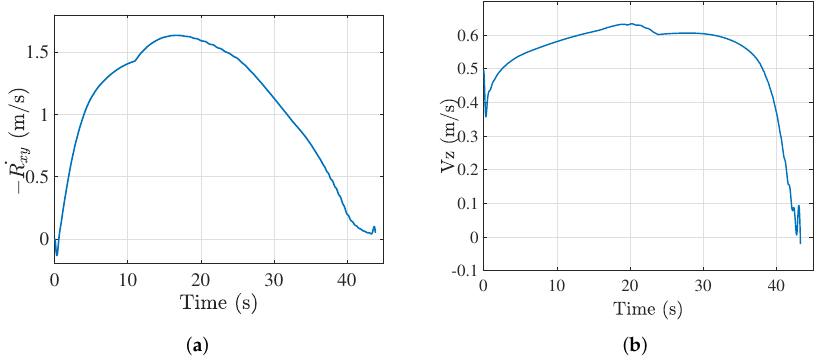
Figure 6. ( a ) Closing velocity profile ( xy plane) of UAV when vehicle moves in a near straight line trajectory at 2 m/s. ( b ) Descend velocity of UAV when ground vehicle moves in a near straight line trajectory at 2